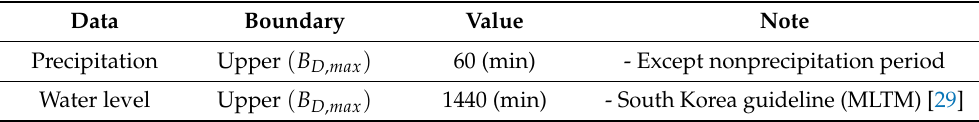
Table 2. Validation boundaries applied for duration check algorithm.